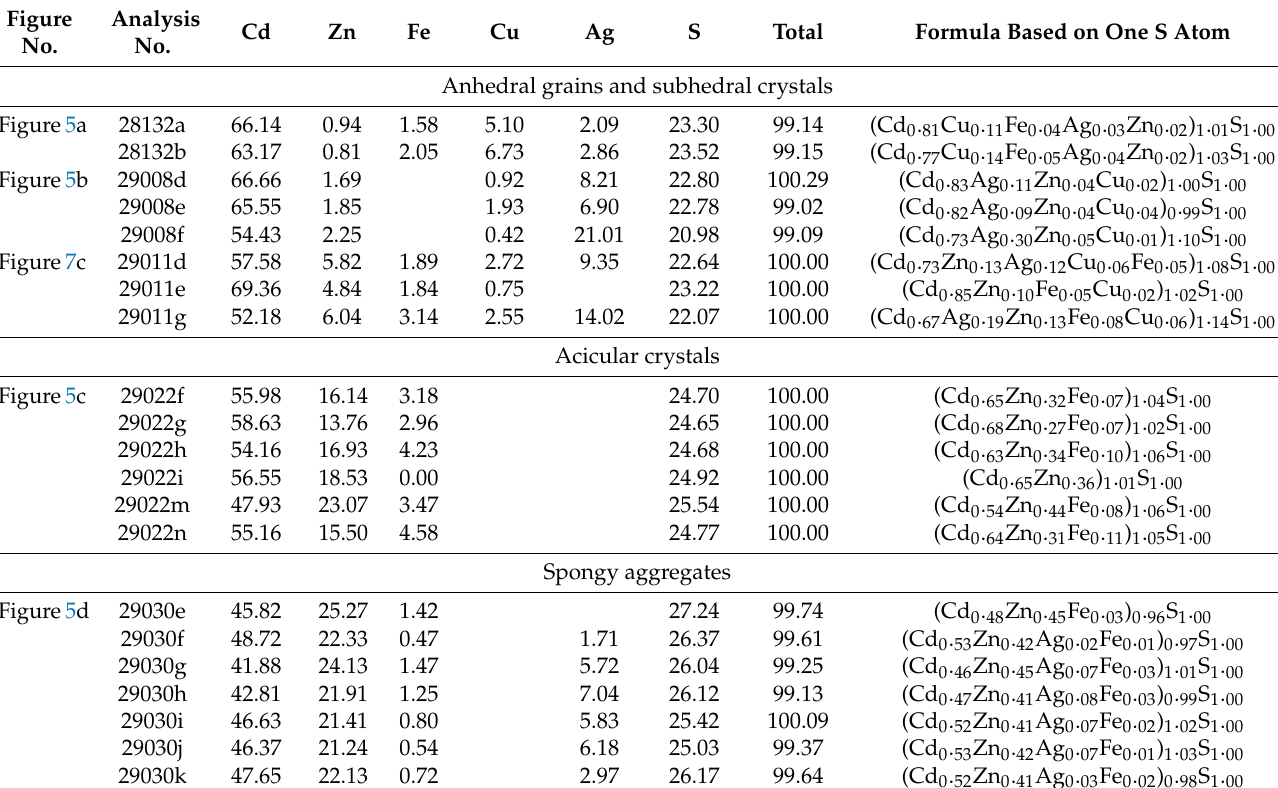
Table 3. Selected chemical composition of the CdS phase from the Irinovskoe HSF, wt%. Figure Analysis No. Figure 5a